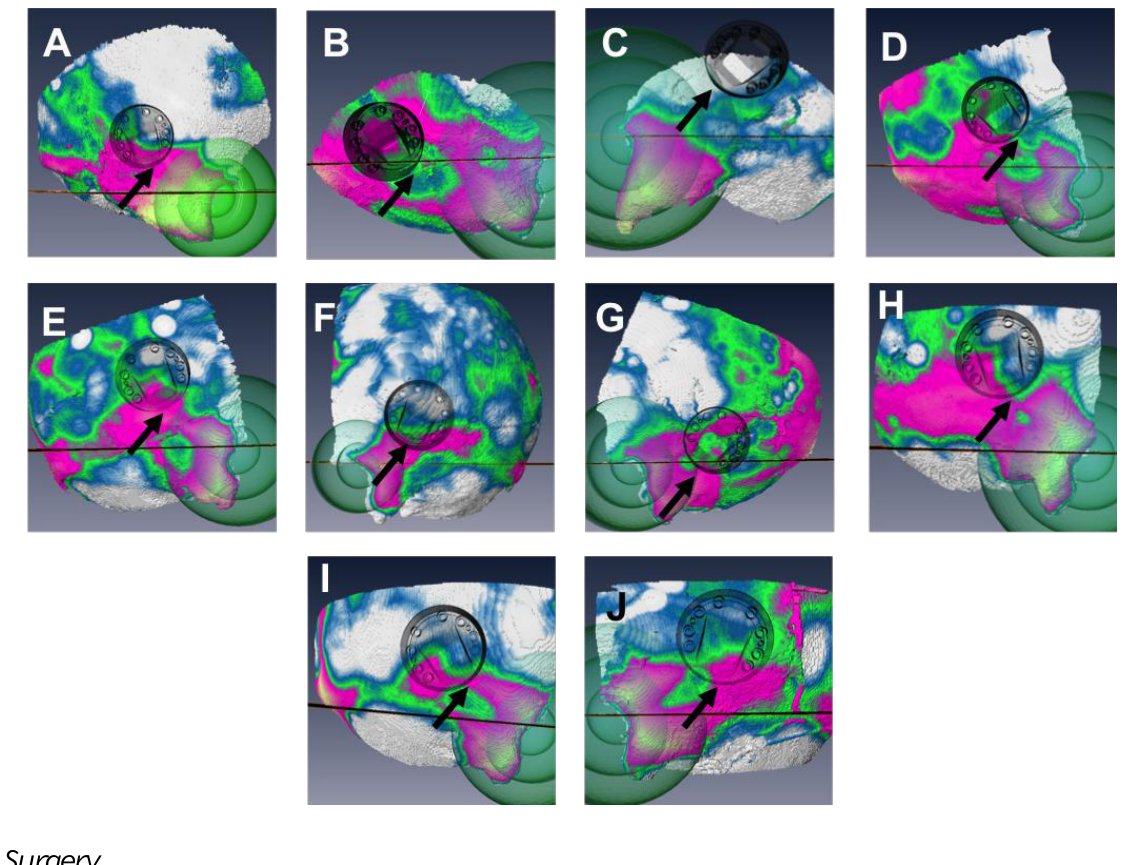
Figure 2. The distance map and actual position of the port after guided surgery in the chronological order ( A – J ). The map shows 4 zones (white: <5 mm; blue: (5–6) mm; green: (6–7) mm; pink/yellow >7 mm). The reference information such as isodistances to the Henle’s spine (green spheres) and the prolongation of the zygoma line (black line) are visible. The black arrow indicates the location of point of deepest necessary